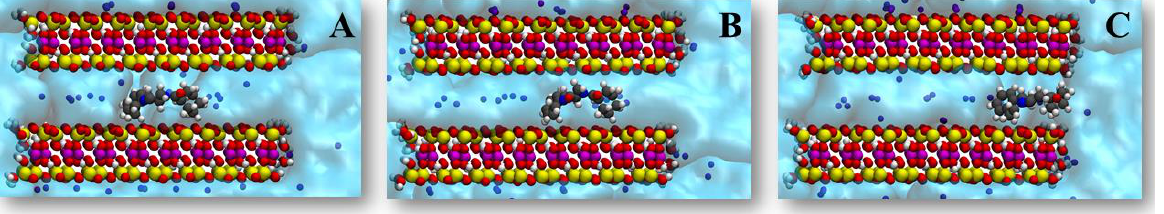
Figure 3. Different initial structures with the praziquantel placed in the center ( A ), between the cen- ter and the edge ( B ), and in the edge ( C ), of the montmorillonite interlayer space.